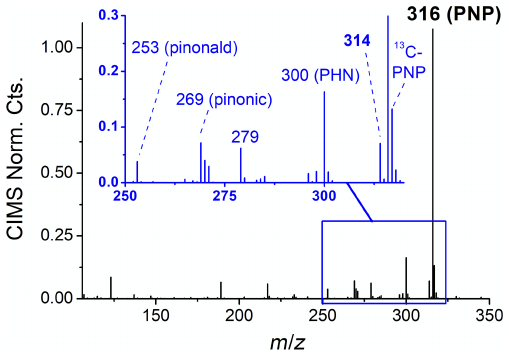
Figure 4. Negative ion CIMS mass spectrum after 1h of oxida- tion under simulated nighttime conditions, showing PNP, PHN, and another organic nitrogen product at m/z 314. Pinonaldehyde is ob- served at m/z 253 and pinonic acid at m/z